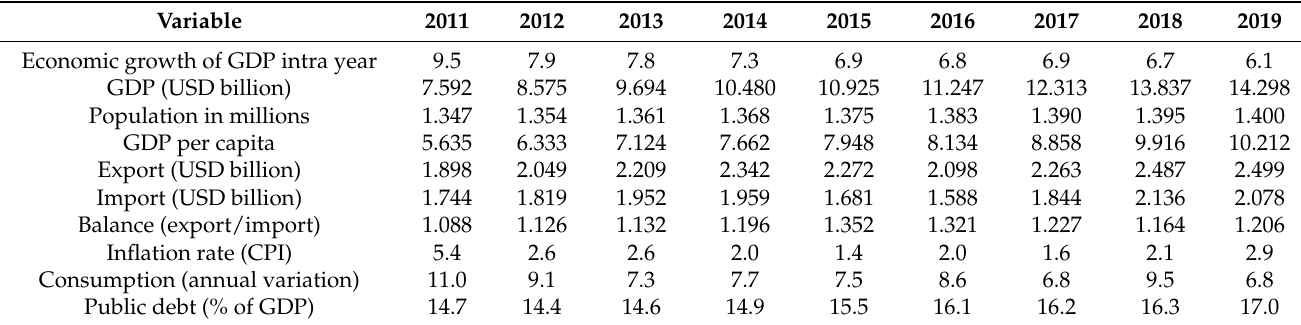
Table 1. Macroeconomic Characteristics of Recent Development